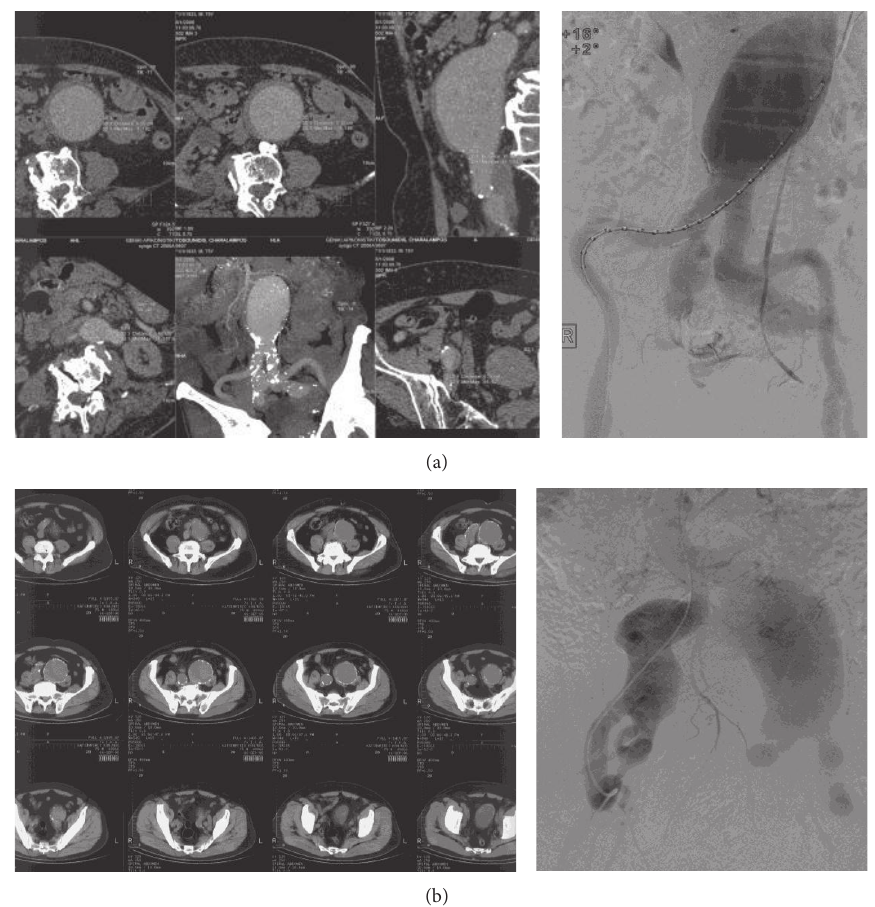
Figure 2: Two cases of complex aortoiliac aneurismal